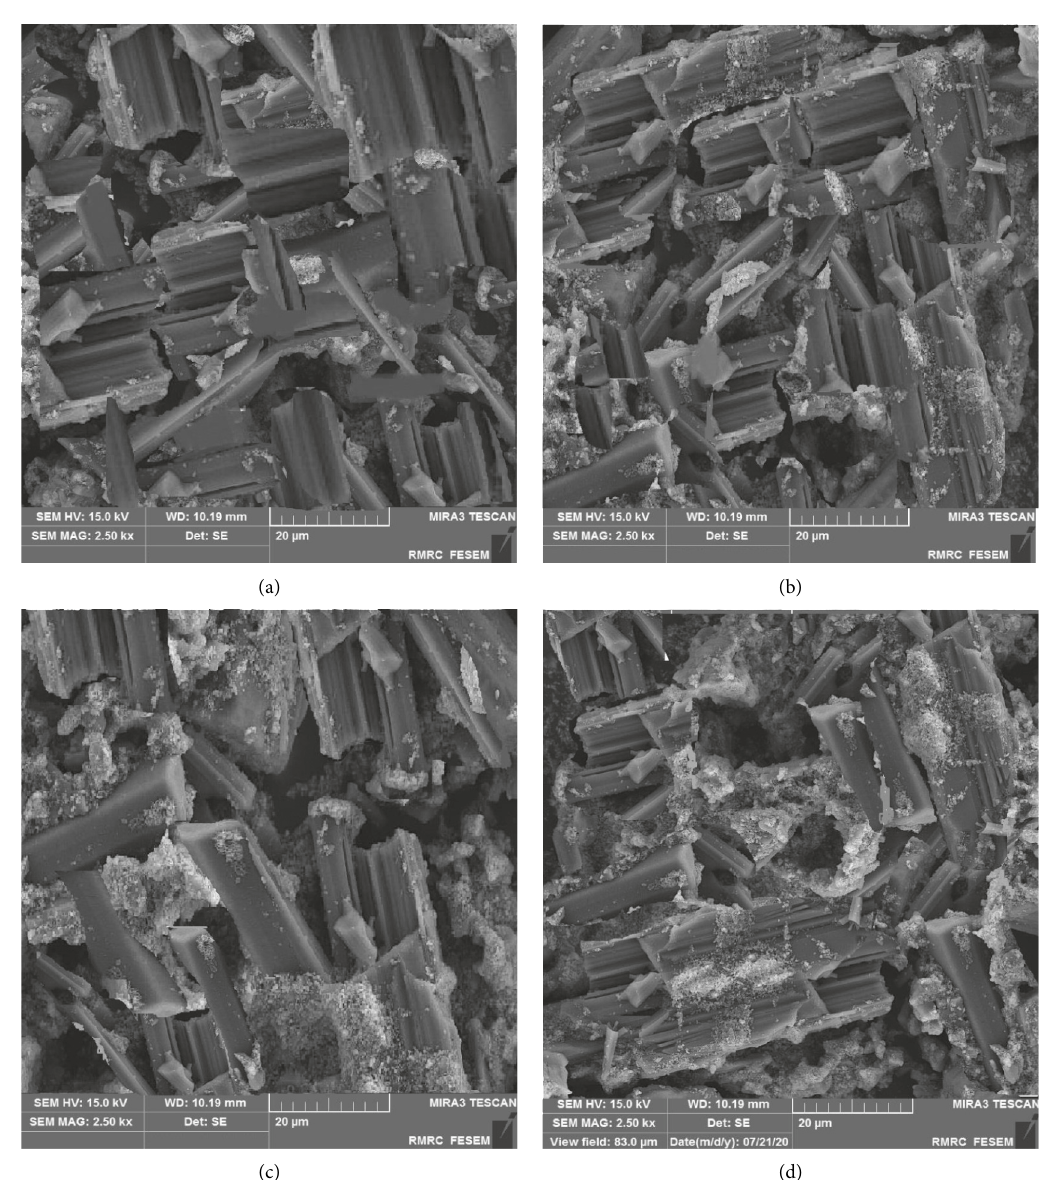
Figure 2: (a) SEM image for stone without silica nanoparticles, (b) stone containing 0.5% silica nanoparticles, (c) stone containing 1% silica nanoparticles, and (d) stone containing 2% silica